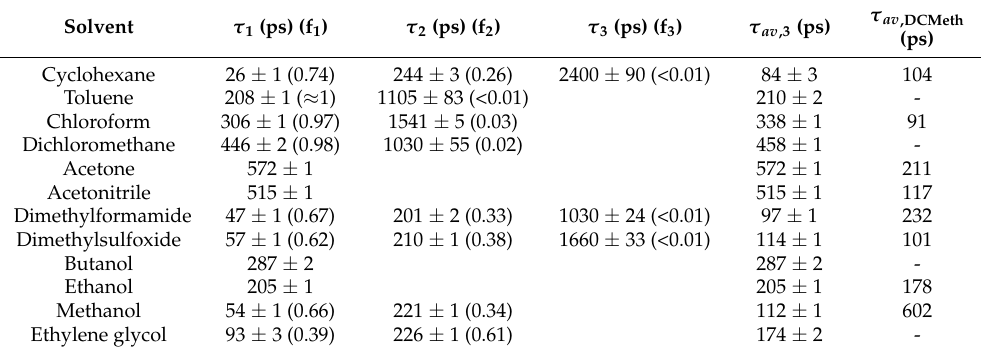
Table 8. Decay times, τ i , and pertaining relative amplitudes resolved in the fluorescence decay distributions measured for 3 in the different solvents of Table 1. In the last two columns, the corresponding average S 1 state lifetimes, τ av , 3 , calculated according to Equation (1), are compared to those of DCMeth, τ av ,DCMeth , reproduced from [39] for the sake of straightforward comparison. Solvent τ 1 (ps) (f 1 ) τ 2 (ps) (f 2 )